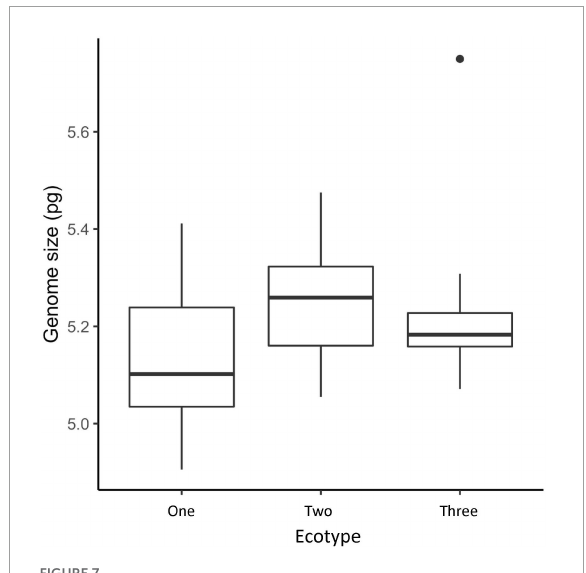
FIGURE7 Genome sizes of the Drakaea livida ecotypes in picograms. Boxes indicate interquartile ranges with the inner line denoting the median